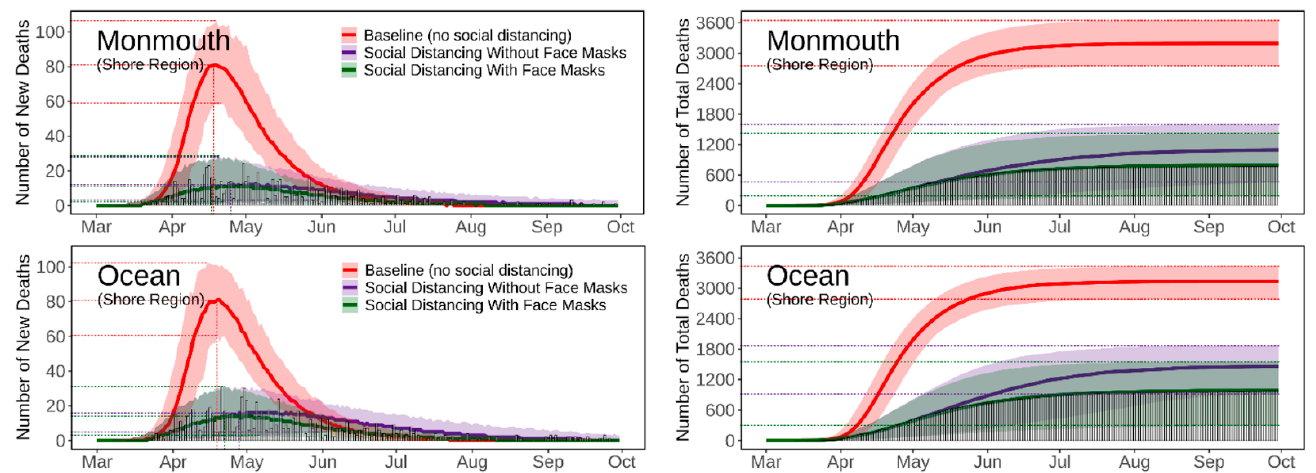
Figure 4. Predicted trajectories of new/total confirmed deaths from COVID-19 corresponding to three exposure scenarios for the counties in the Gateway Region of NJ, March to September 2020, compared with reported death data (vertical bars). The color-shaded areas depict the 95% Confidence Interval (CI) of the corresponding predictions.